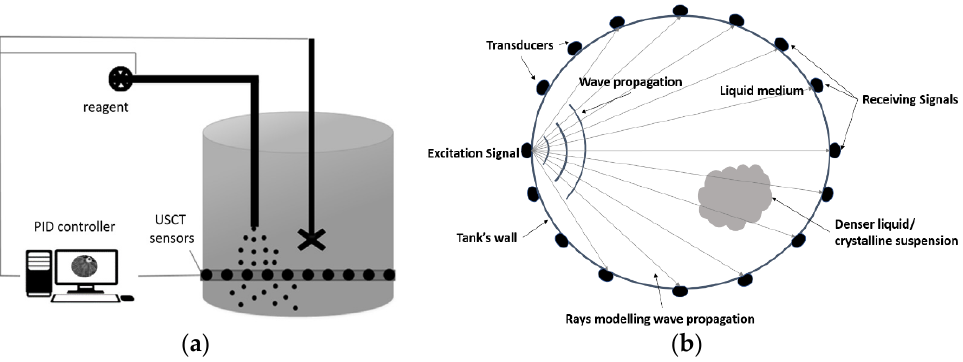
Figure 1. ( a ) Graph depicting ultrasound computed tomography (USCT) applied in an automatic control of batch crystallisation scenario. ( b ) Travel-time tomography functionality (panoramic view).